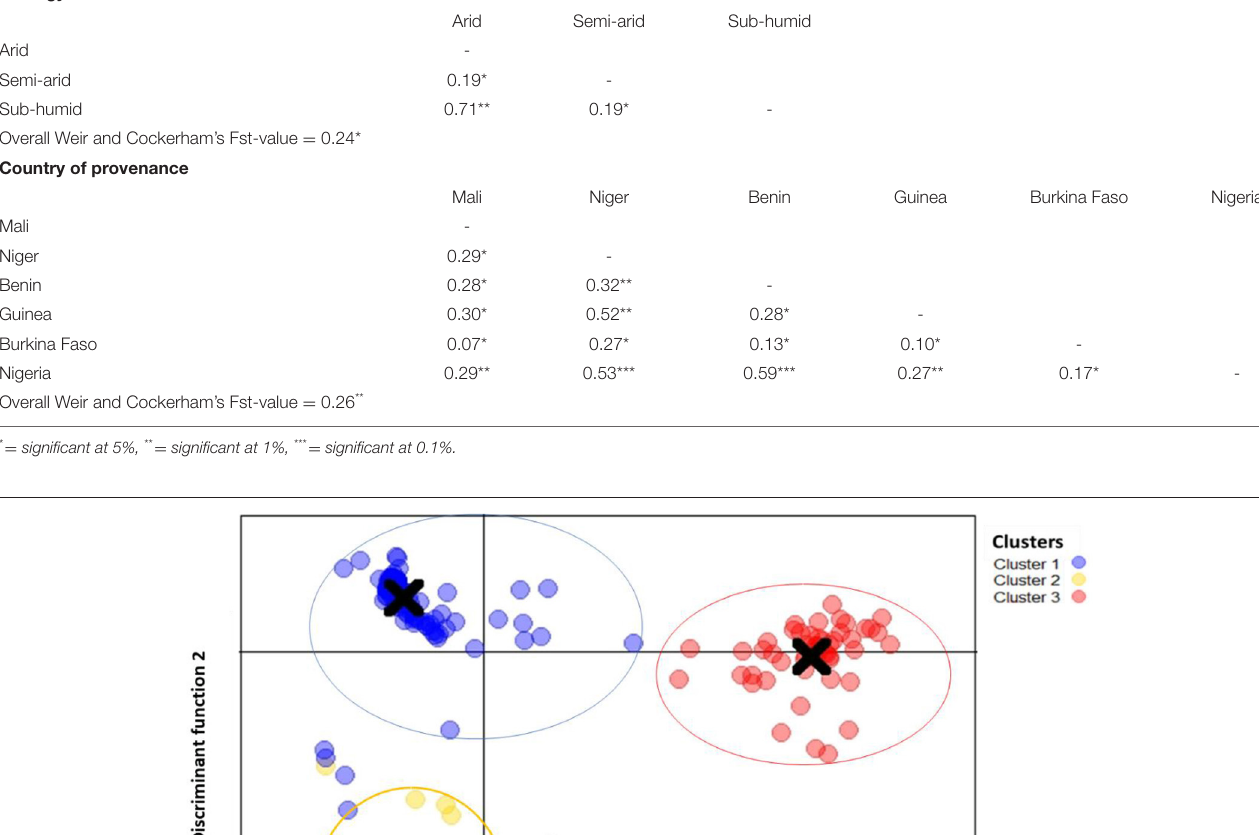
TABLE 6 | Pairwise Fst analysis results among ecological regions and countries of provenance of 259 fonio millet accessions. Ecology Arid - Semi-arid 0.19* - Sub-humid 0.71** Overall Weir and Cockerham’s Fst-value = 0.24* Country of provenance